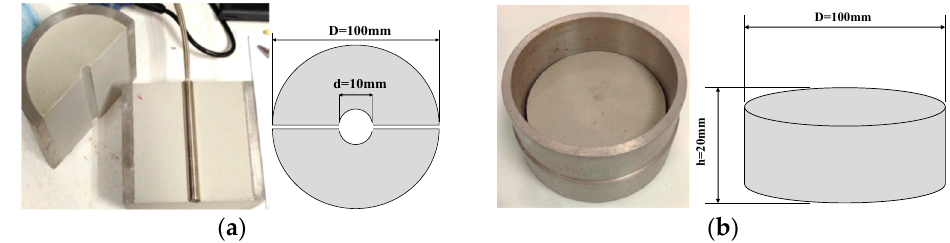
Figure 2. Specimen preparation for ( a ) NP method and ( b ) TPS method.